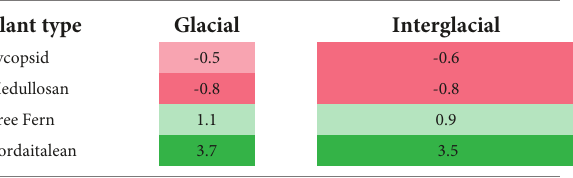
TABLE 5 Simulated hydraulic safety margin from embolism for four extinct plant types using Paleo -BGC (White et al., 2020) under tropical sub-humid